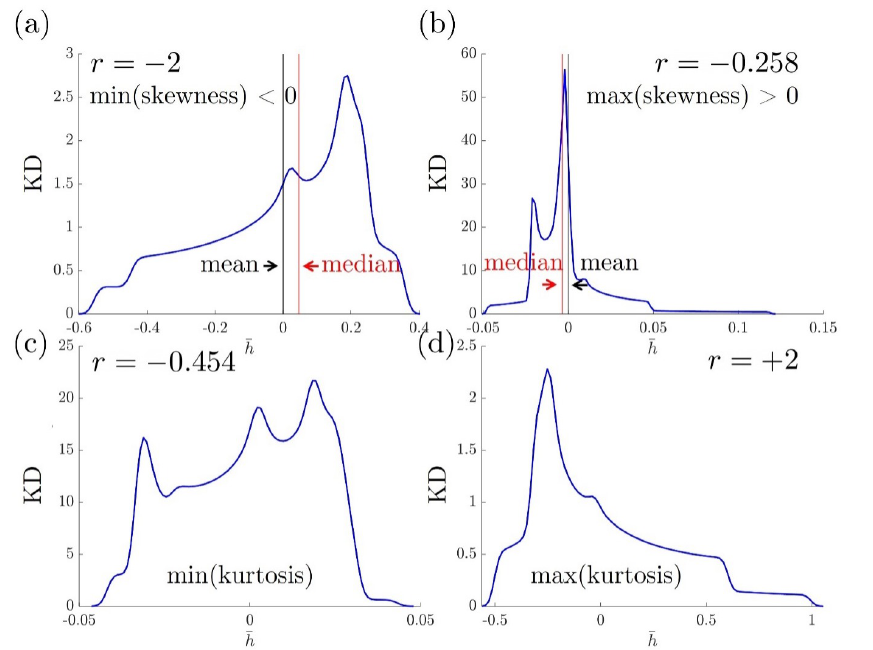
Figure 8. The kernel density (KD) when ( a ) r = − 2 (minimum skewness), ( b ) r = − 0.258 (maximum skewness), ( c ) r = − 0.454 (minimum kurtosis) and ( d ) r = + 2 (maximum